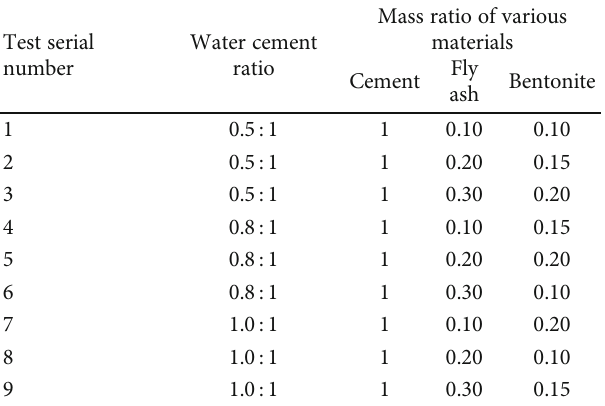
Table 2: Orthogonal test group distribution ratio